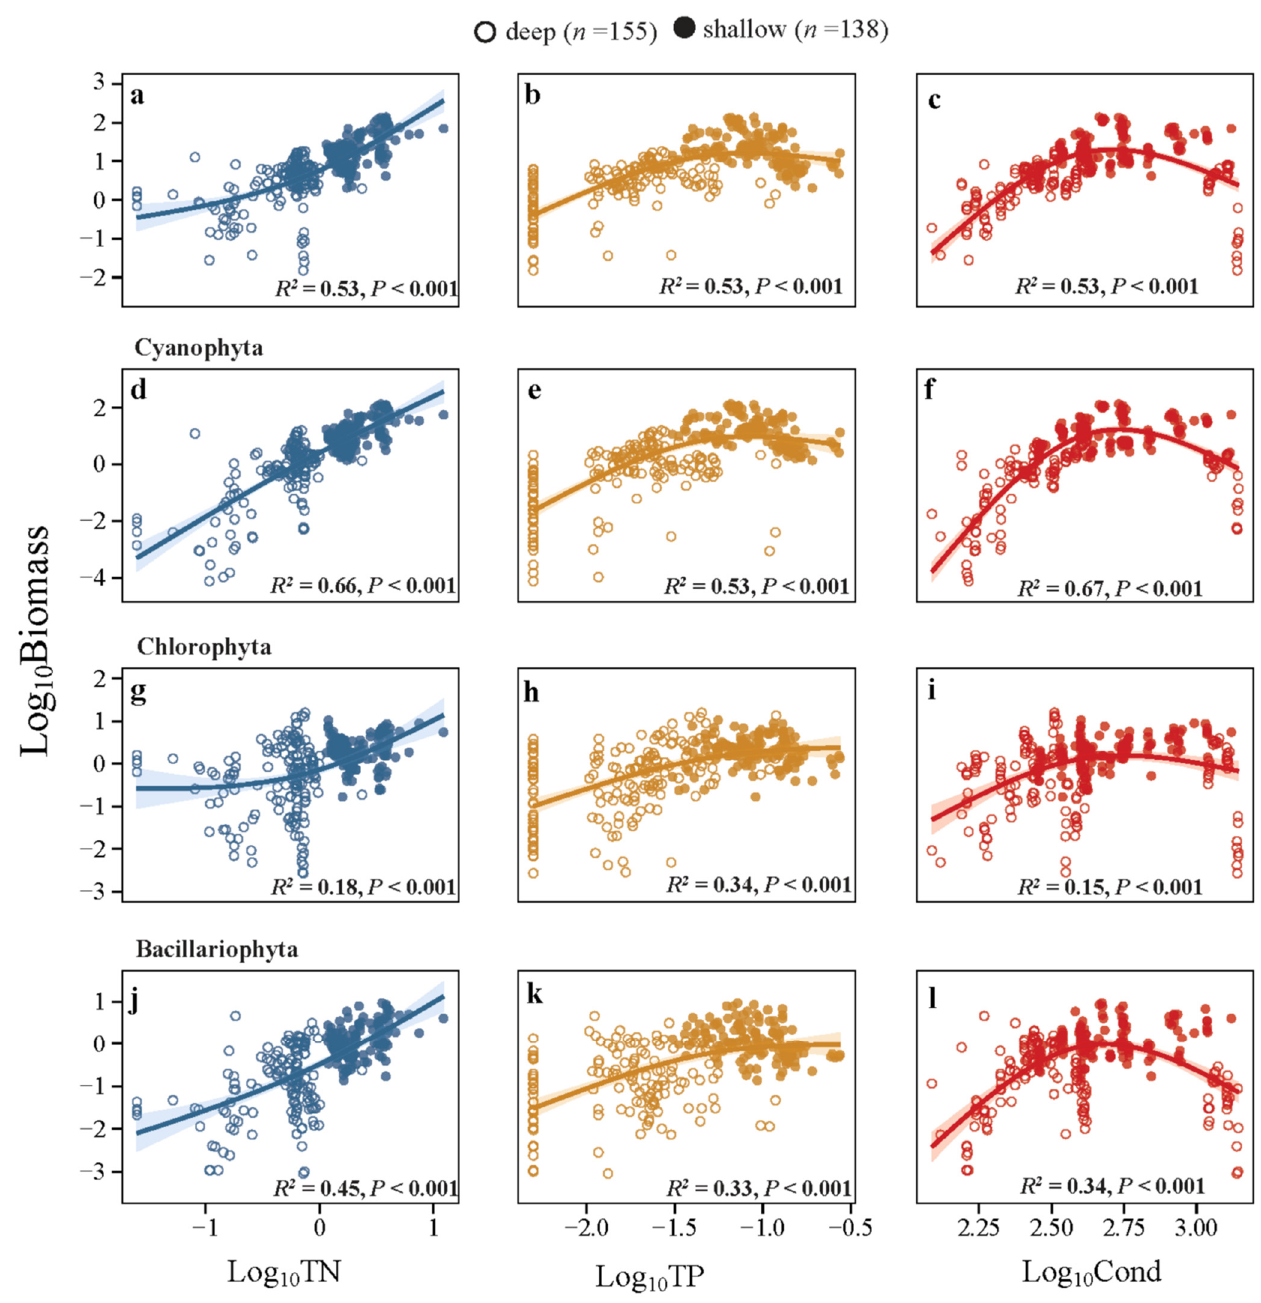
Figure 3. Generalized additive model showing the relationships between TN, TP, and Cond and total biomass ( a – c ), cyanophyta ( d – f ), chlorophyta ( g – i ), and bacillariophyta ( j – l ) in the studied lakes. See Figure 3 and Table S1 for model parameters used in the classification of deep and shallow lakes.